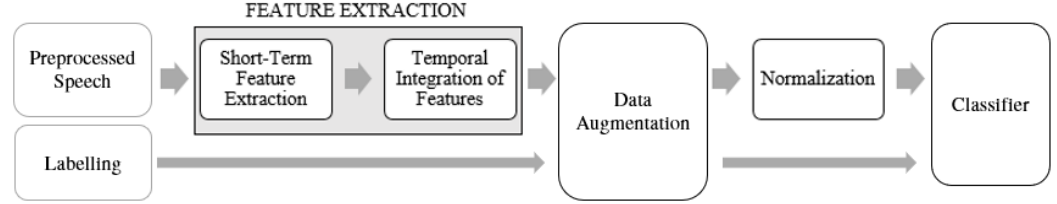
Figure 2. Block diagram of the system.